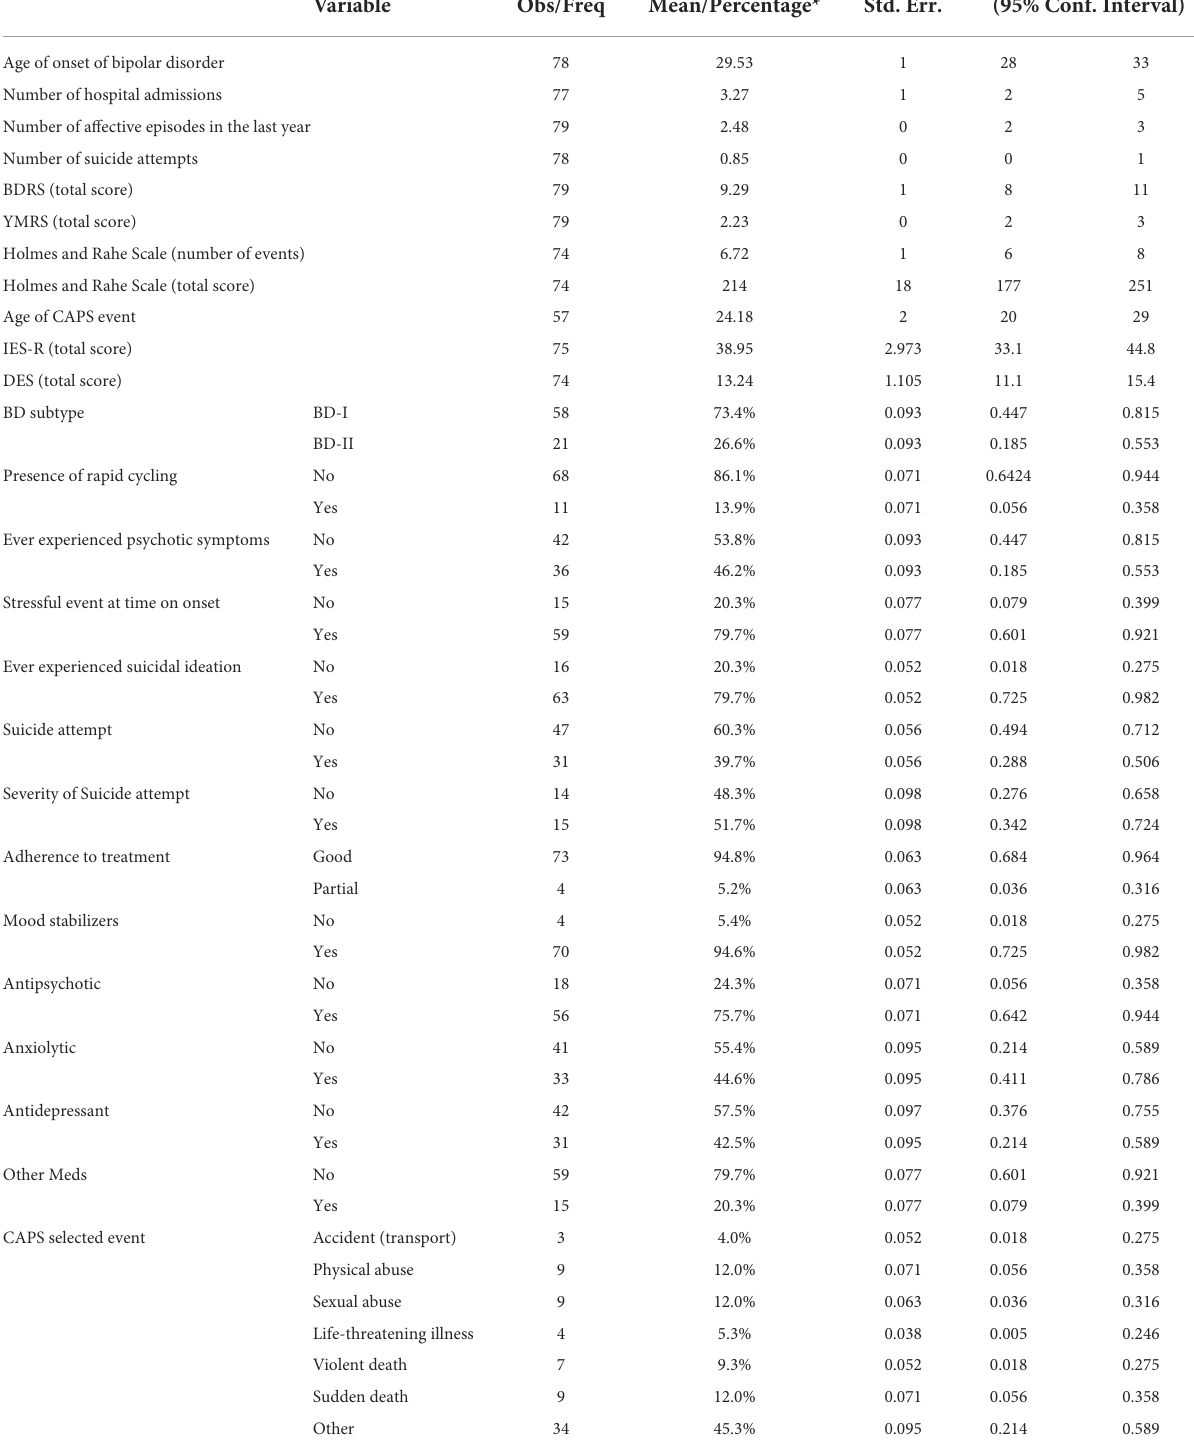
TABLE 2 Clinical characteristics of the sample. Variable Obs/Freq Mean/Percentage* Std.